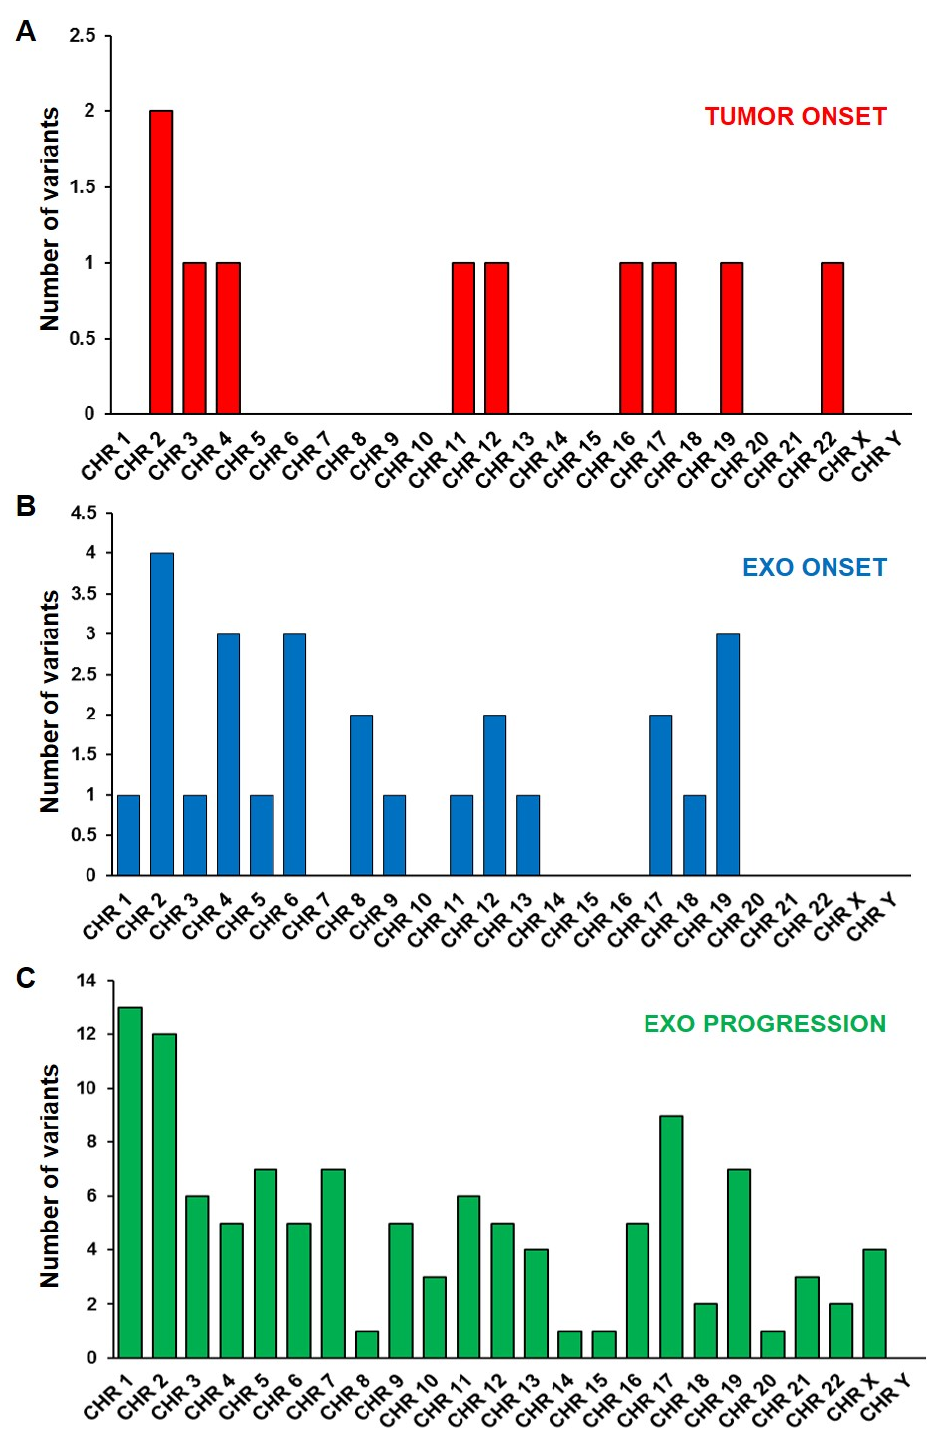
Figure 4. Chromosomes’ localization of somatic SNVs in ( A ) tumor DNA at onset, ( B ) exo-DNA at onset, and ( C ) exo-DNA at disease progression.